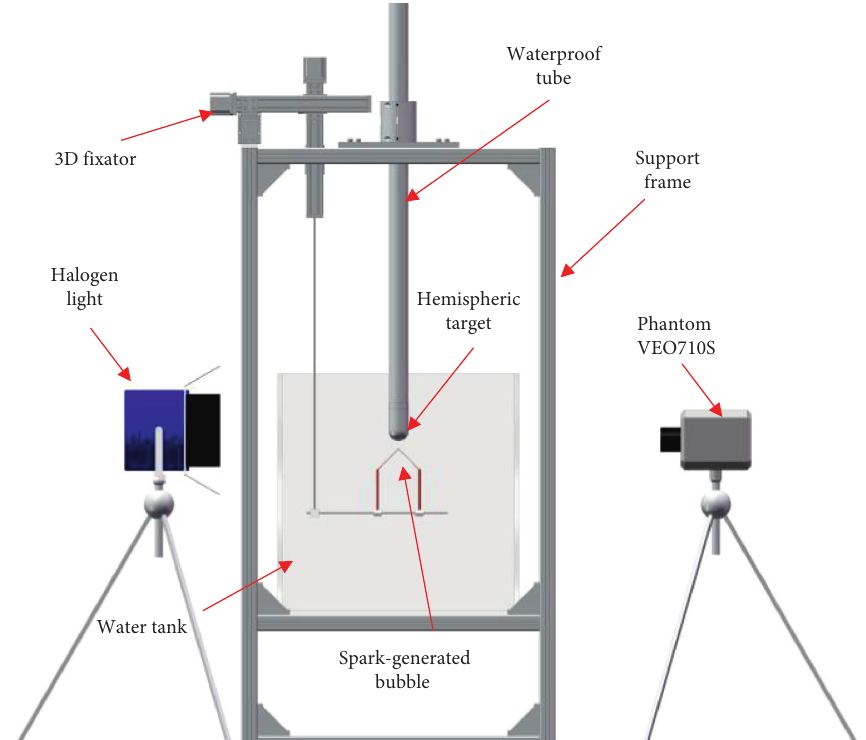
Figure 2: Experimental system schematic.